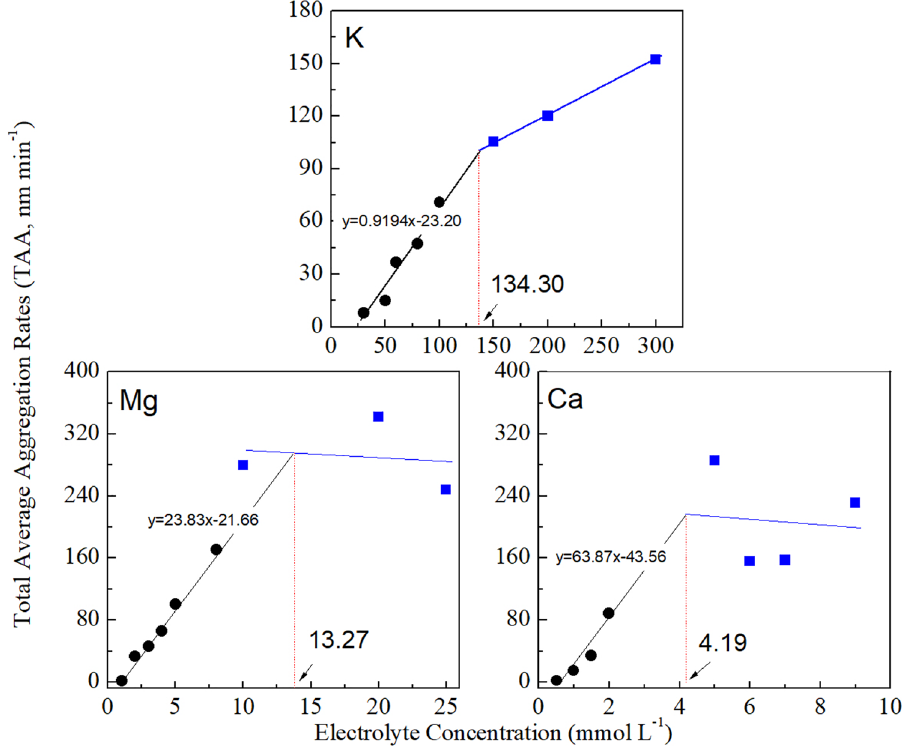
Figure 5. The TAA rates for the aggregation of the BSC particles as a function of the electrolyte concentration in K + , Mg 2+ and Ca 2+ electrolytes.